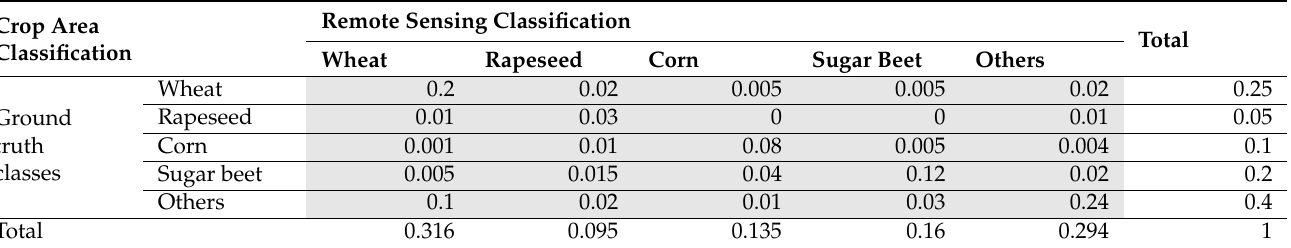
Table 2. Joint probabilities for the artificial data